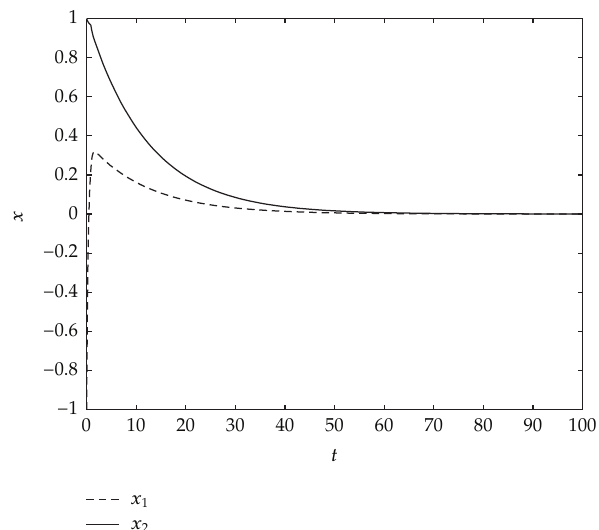
Figure 4: The trajectory of solution of system i (cid:8) 2 under the feedback controller (cid:6) 4.4 (cid:7)